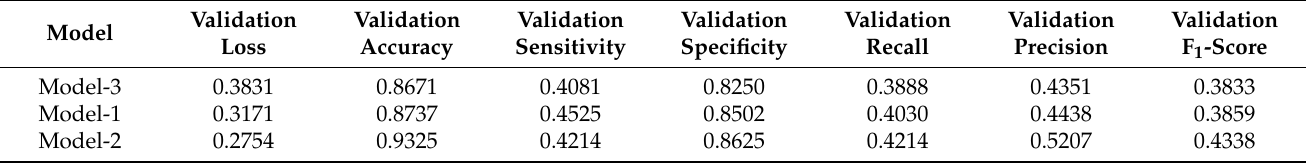
Table 4. Validation results of the models used in the study.